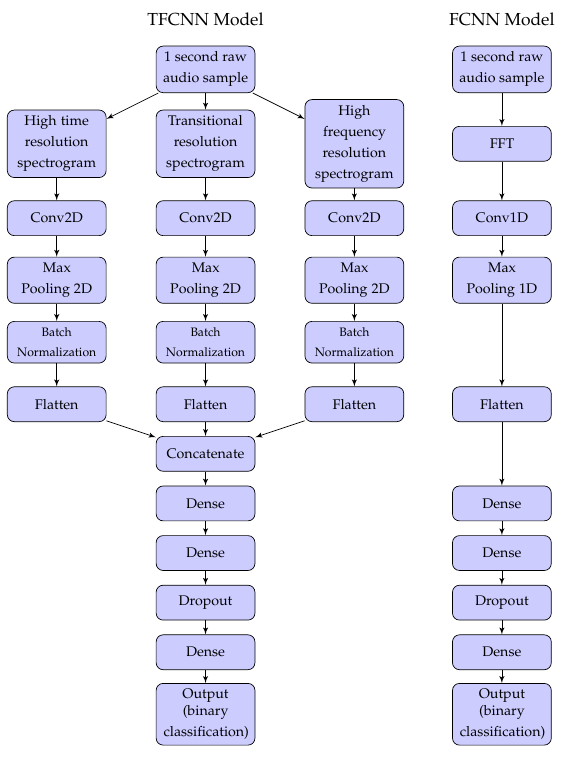
Figure 7. TFCNN and FCNN model